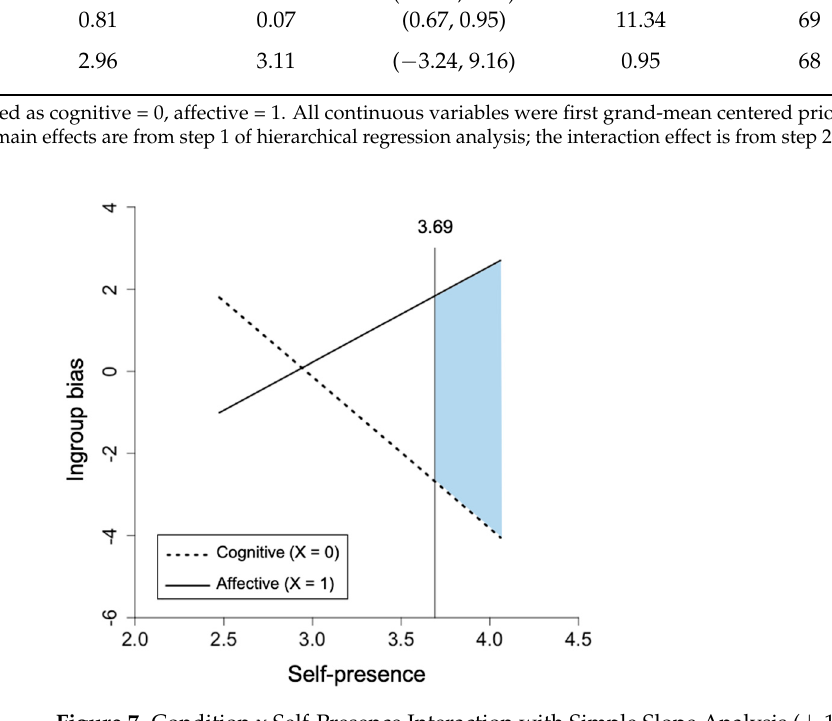
Figure 7. Condition x Self-Presence Interaction with Simple Slope Analysis ( ± 1SD) for Ingroup Bias Measured By Attitudes. Note. Condition is significant within the shaded (Johnson–Neyman) regions.